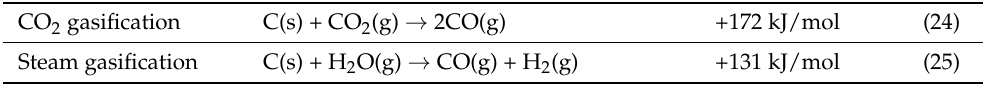
Table 5. Coke gasification reactions using H 2 O or CO 2